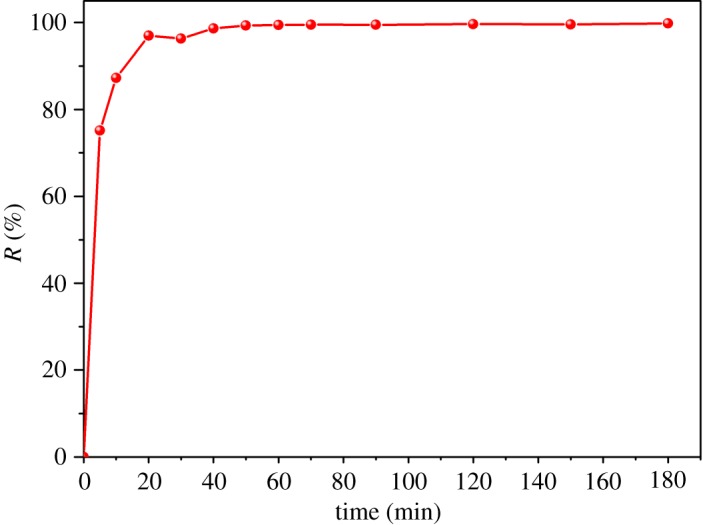
Effect of the contact time on the removal of MB (C0 = 20 mg l−1, m = 10 mg, T = 30°C, pH = 7, v = 100 ml).